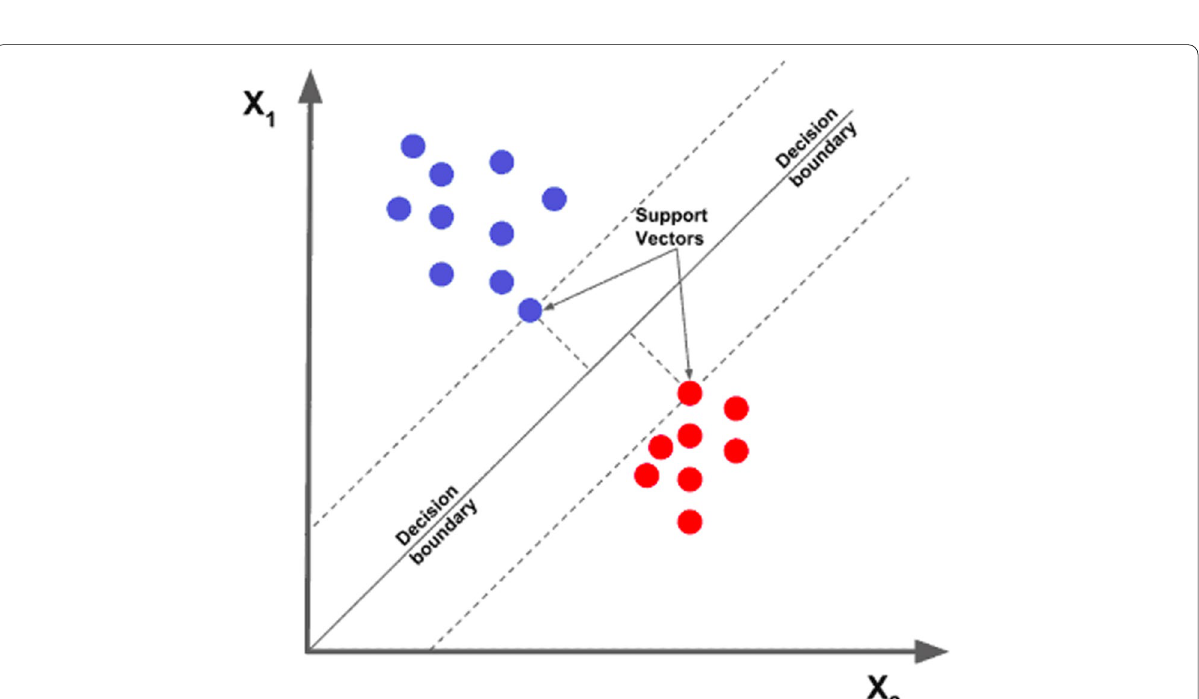
Fig. 6 Support vector machine